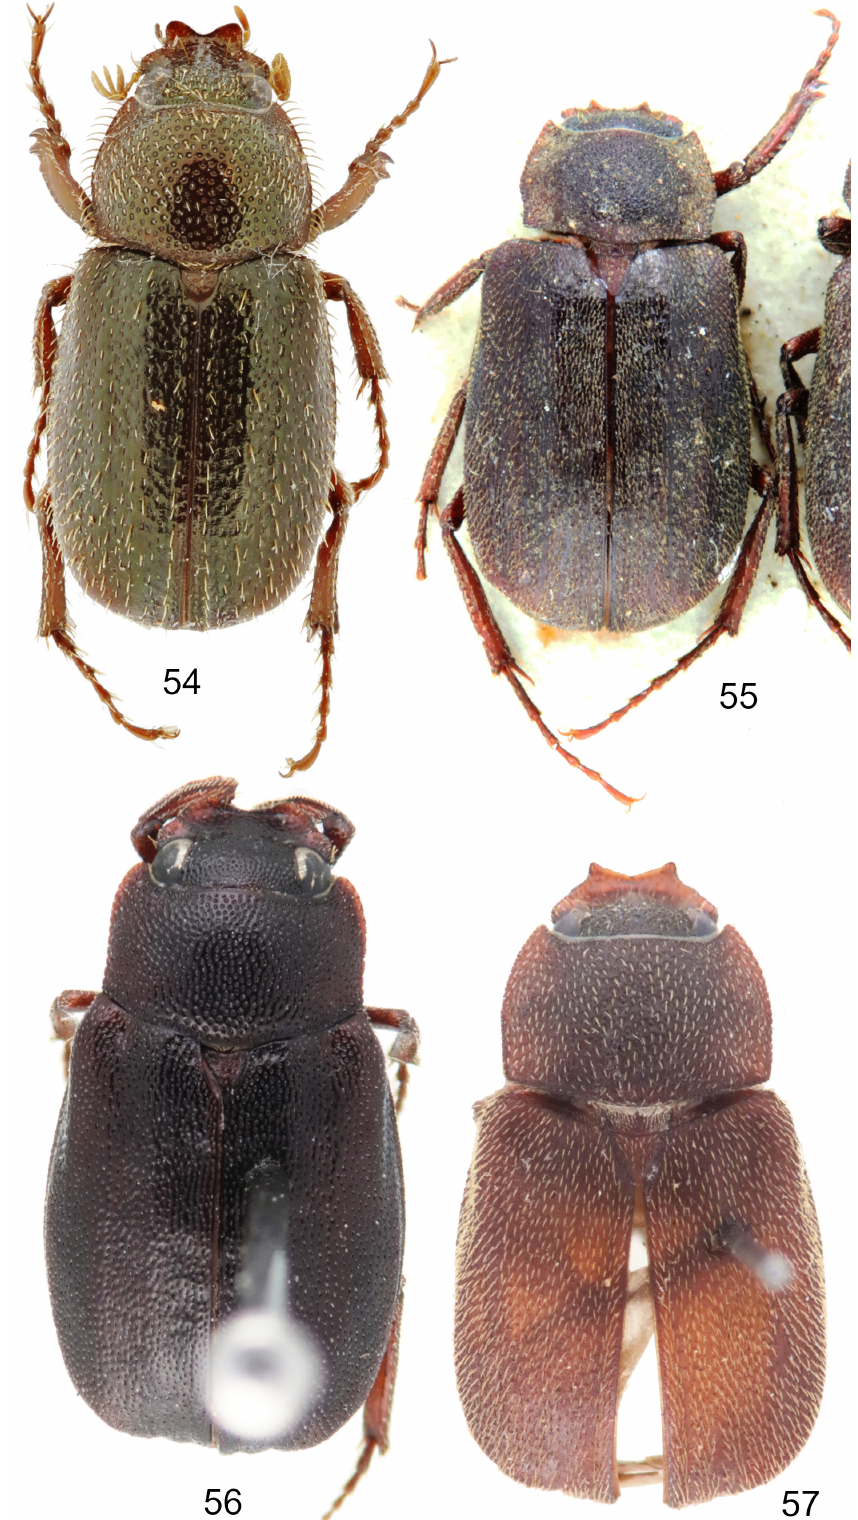
Figs 54–57. Papuan and Wallacean Maechidius Macleay, 1819, habitus, dorsal view. 54 . M. lobaticeps Frey, 1969, ♂ (DTC). 55 . M. longipes sp. nov., holotype, ♂ (BMNH). 56 . M. mailu sp. nov., holotype, ♂ (NHMB). 57 . M. luniceps Fairmaire, 1883, ♂ (BMNH). Not to